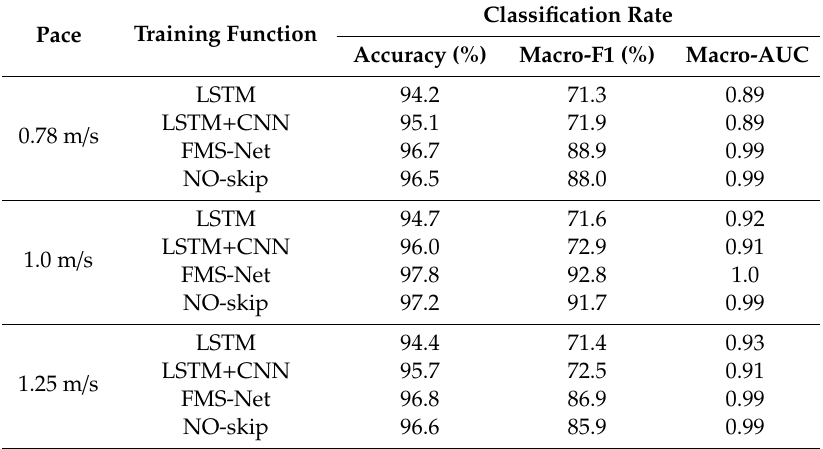
Table 3. Summary of classification performance for di ff erent training